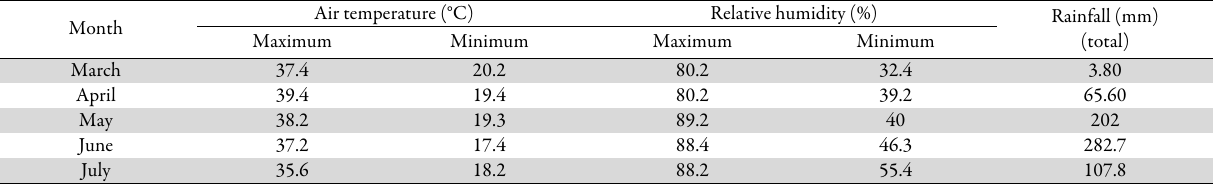
Table 2. Monthly record of air temperature, relative humidity and rainfall of the experimental site during the period of March to July 2014 and 2015 (Mean of two years)